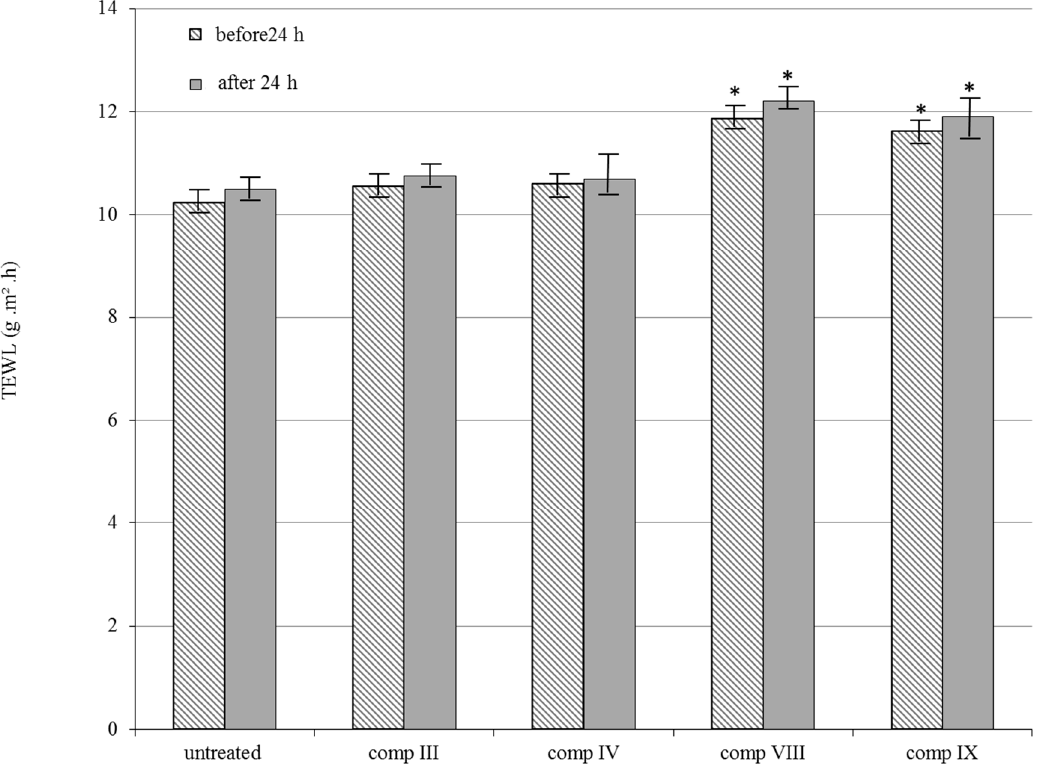
Figure 4. In vivo skin irritation examination. Changes in TEWL value before and after 24 h application of the selected silymarin creams III, IV, VIII, IX on the dorsal skin of guinea pigs. Each data point represents the mean ± S.D., n = 5. Repeated-Measures ANOVA and Pearson correlation tests were performed. Significant differences were marked with * , which show the significance levels in the case of compositions VIII and IX before and after 24 h compared to the untreated controls.